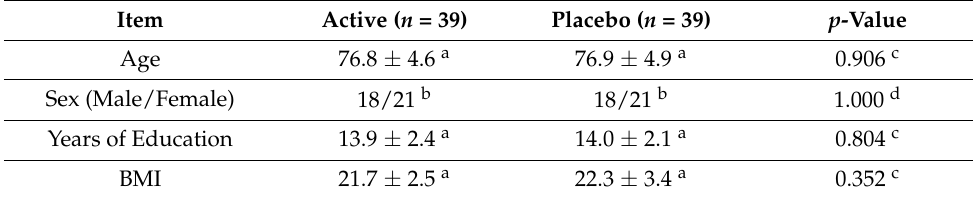
Table 1. Participant characteristics.